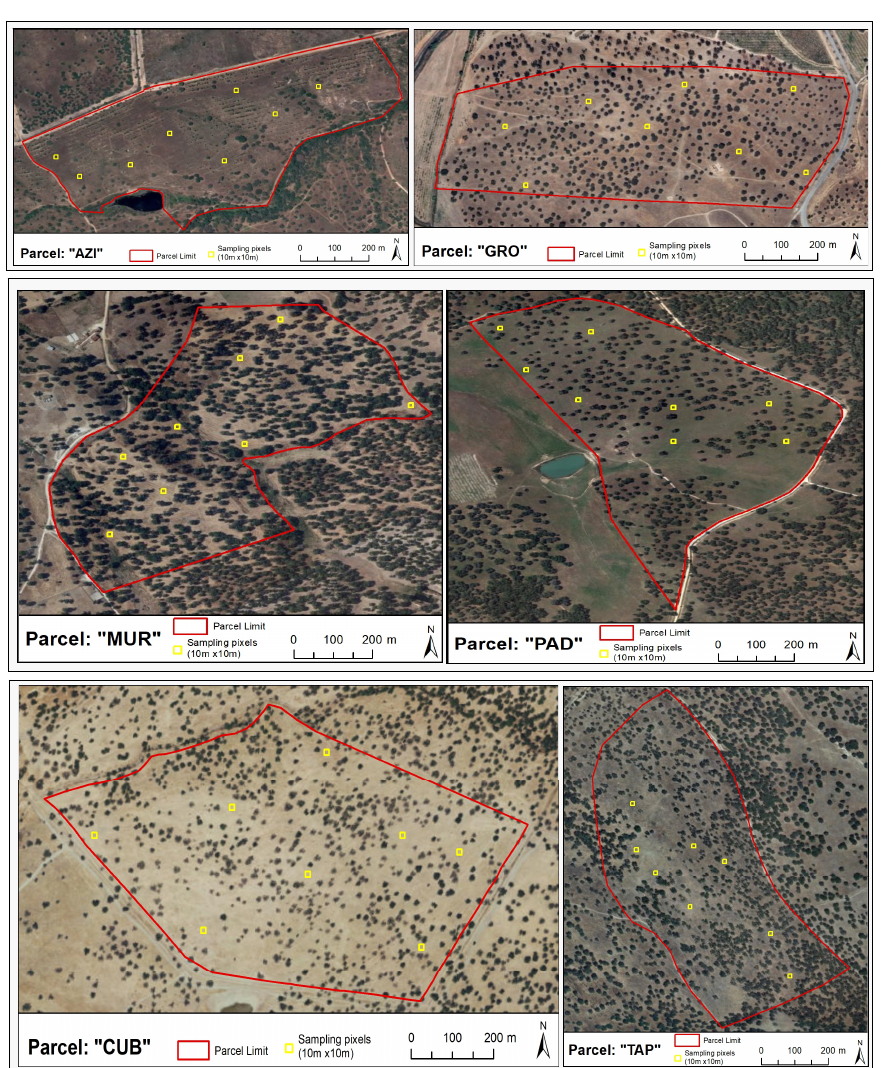
Figure 4. Eight “10 m × 10 m” sampling areas georeferenced in each of the six experimental fields. 2.4. Normalized Difference Vegetation Index (NDVI) Measurements with Proximal Optical